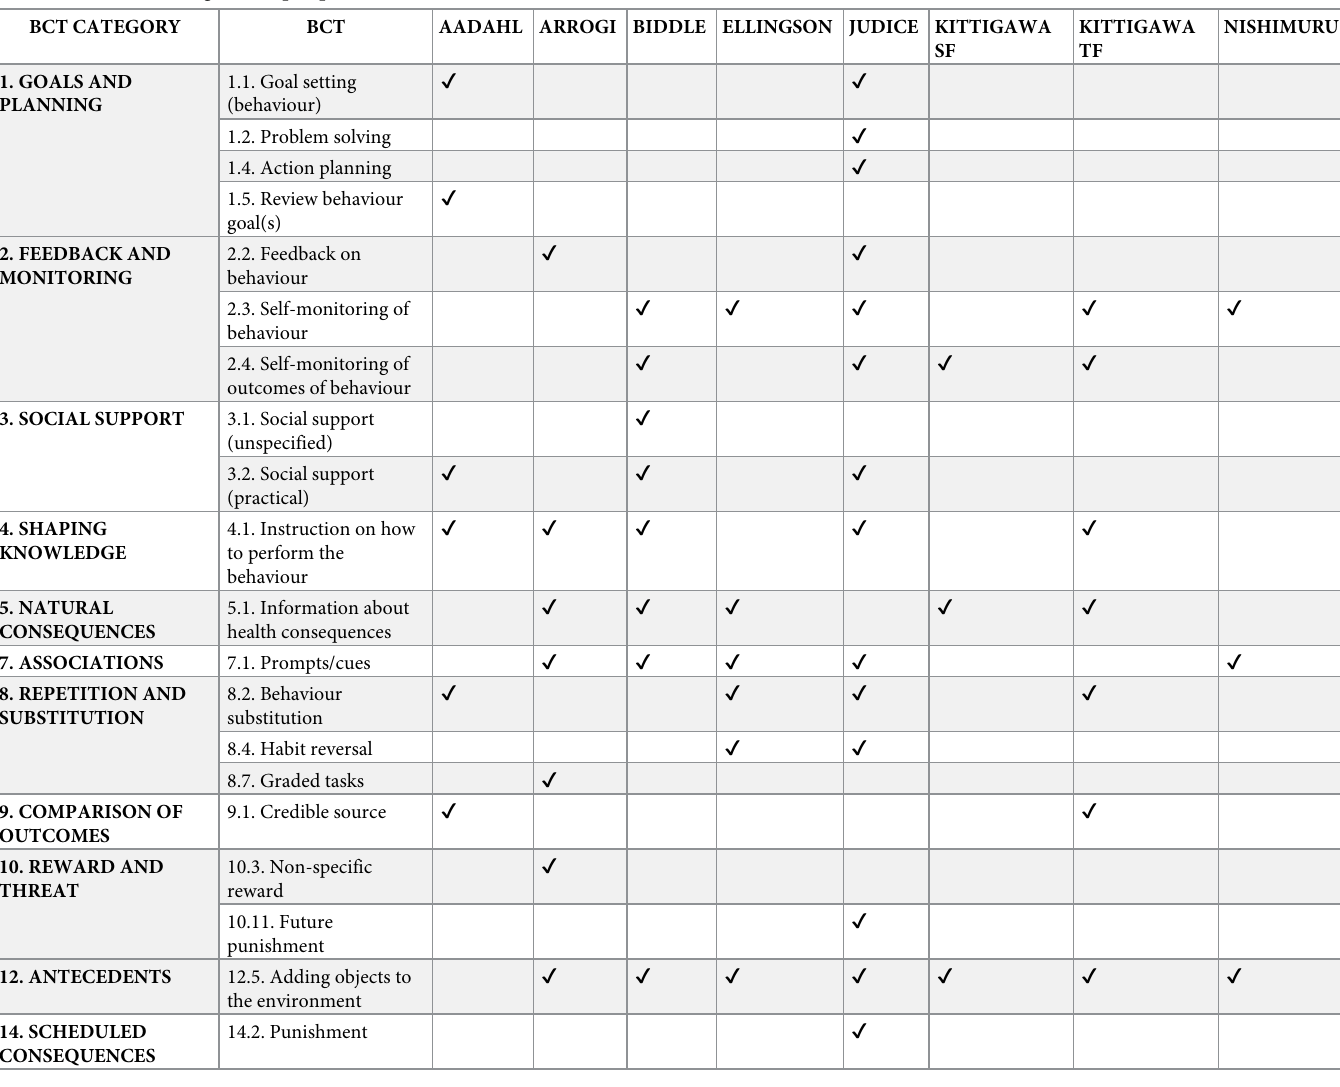
Table 4. Behaviour change techniques per